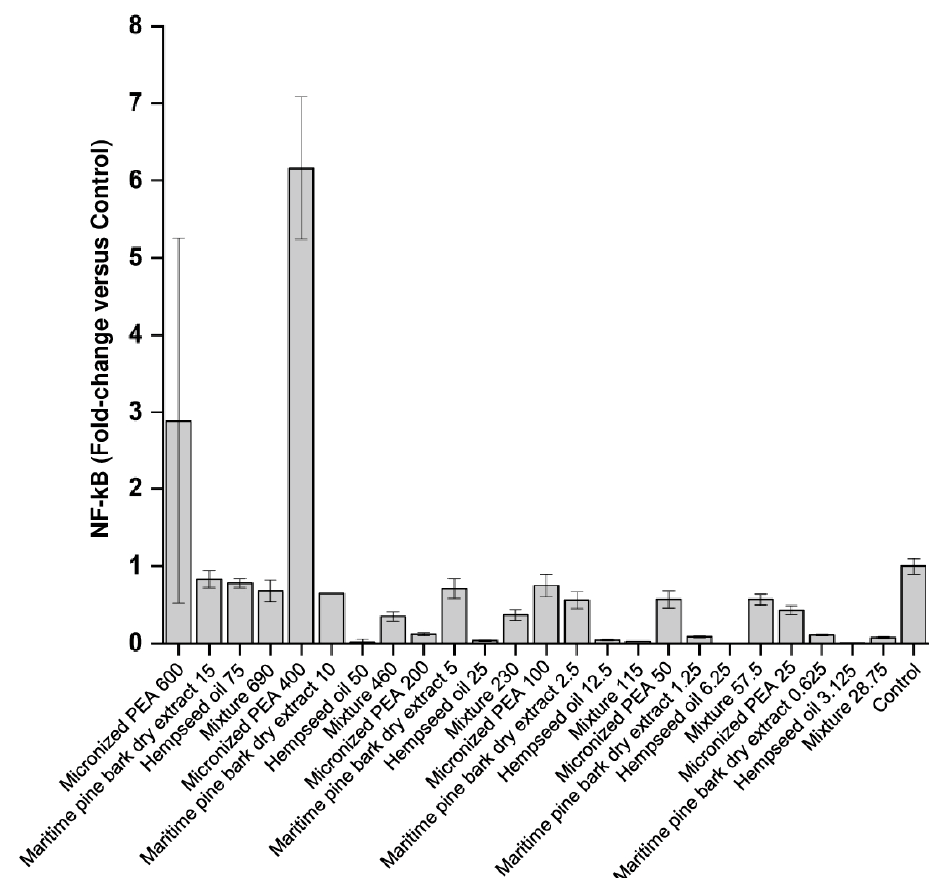
Figure 3. Nuclear levels of the transcription factor NF-kB expressed as fold changes compared to control (cells treated with medium conditioned only with the inflammatory stimulus, E. coli ) after treatment of bladder urothelium cells with the three functional ingredients and their mixture at different concentrations.